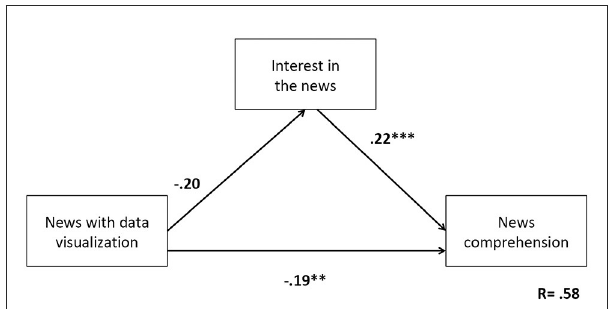
FIGURE1 Effect of interest on comprehension in data visualization. Model: independent variable—type of news; mediating variable—interest